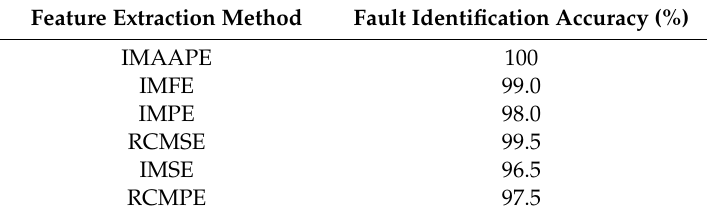
Table 19. Gearbox fault identification accuracy of di ff erent fault extraction methods combined with the